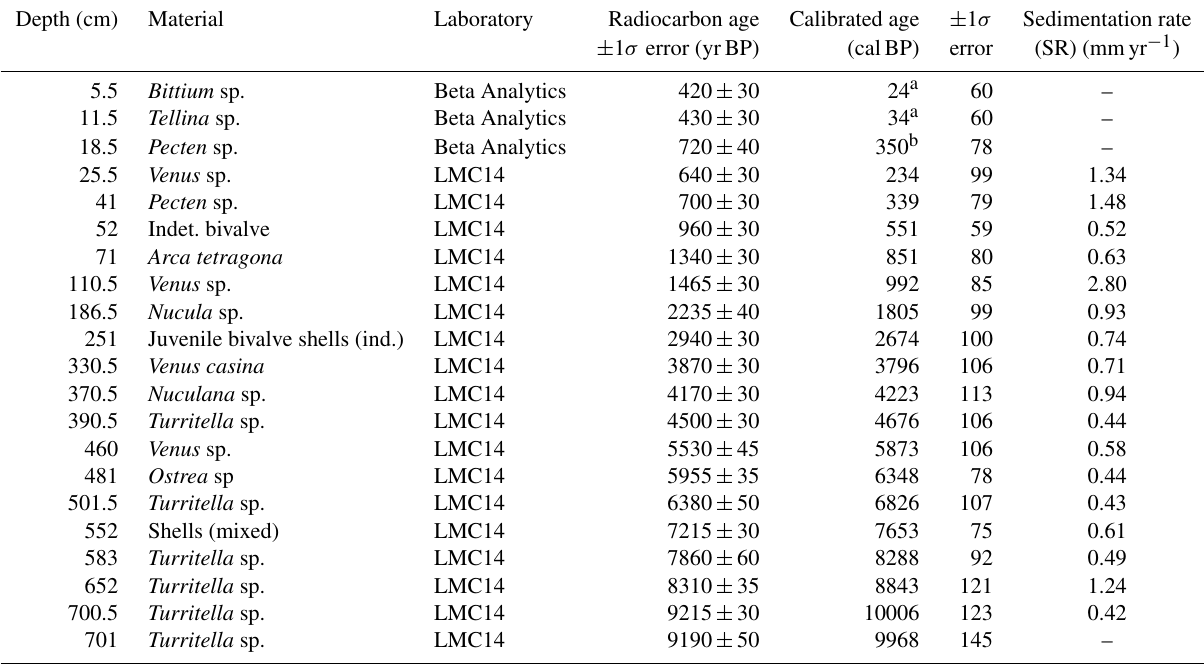
Table 2. 14 C dates obtained from core